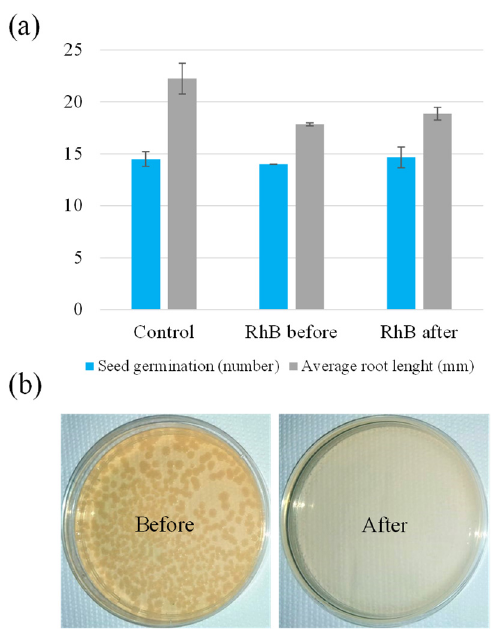
Figure 9. ( a ) Seed germination test for toxicity analysis of RhB solutions. ( b ) Growth of E. coli on agar plate before the EC treatment and after 40 min of exposure of E. coli to EC treatment.